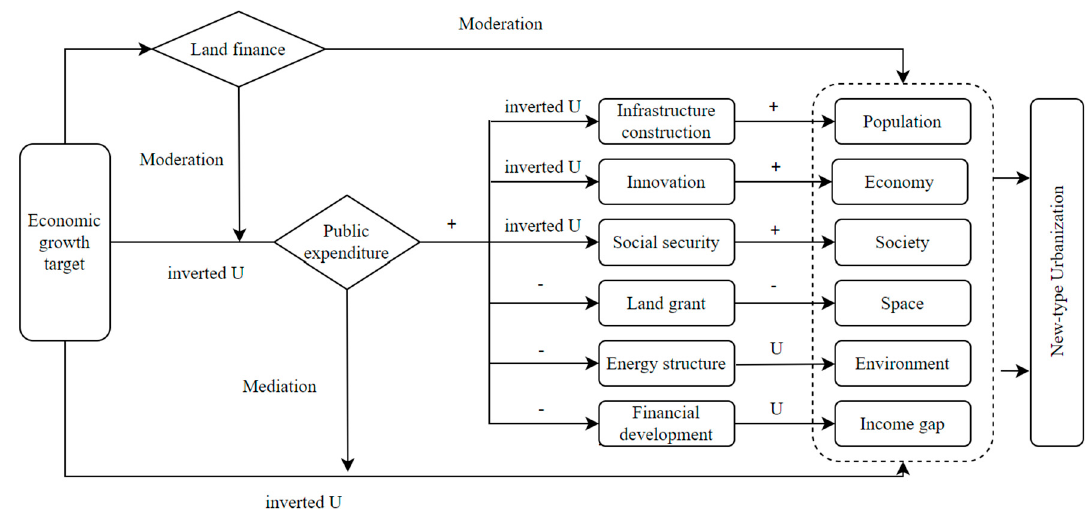
Figure 1. Research framework.